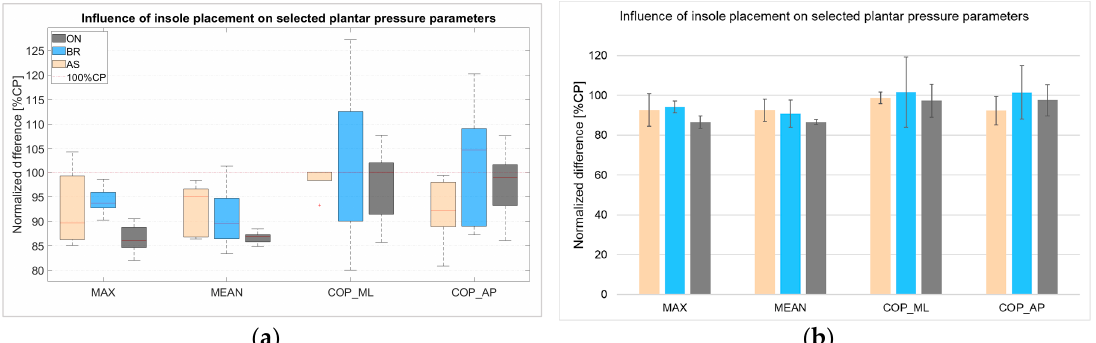
Figure 2. Results for the evaluation of the influence of pressure-sensing insole placement on the selected parameters, MAX, MEAN, COP_ML, and COP_AP, separately for each tested running shoe. Bright flesh-colored boxes/bars represent the Asics GEL-NIMBUS 18, blue boxes/bars represent the Brooks Gylcerin 14, and dark grey boxes/bars represent the On Cloudflyer. In (a) boxplots show the median (red line), 25th to 75th percentile, and outliers. In ( b ) bars and error bars show the mean and standard deviation.